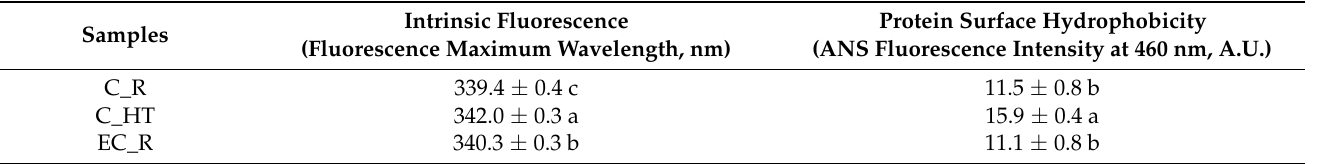
Table 2. Front-face fluorescence protein conformational indices of pasta from red